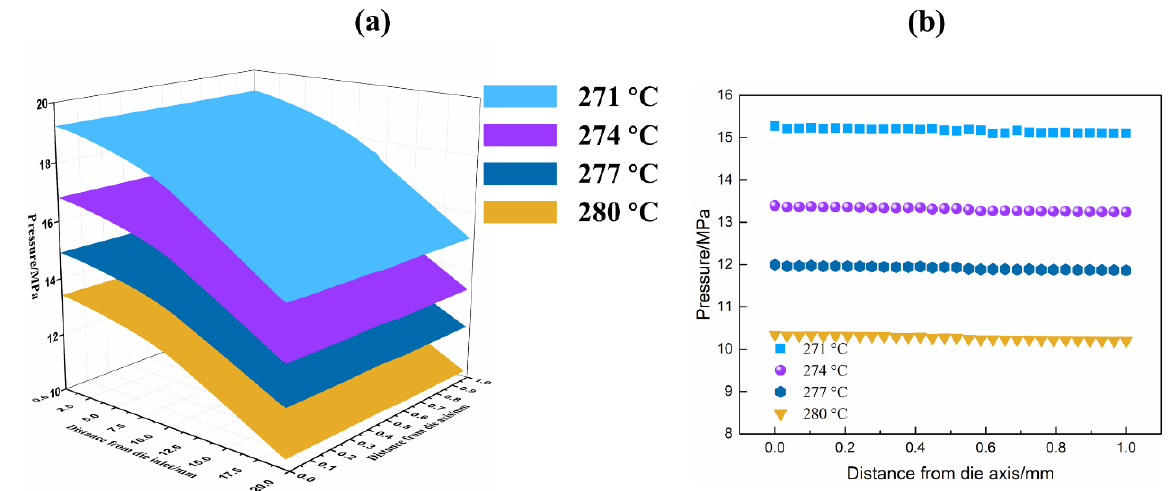
Figure 7. ( a ) Pressure inside the die channel for PET melts and ( b ) pressure along the die exit for PET melt at different temperatures.